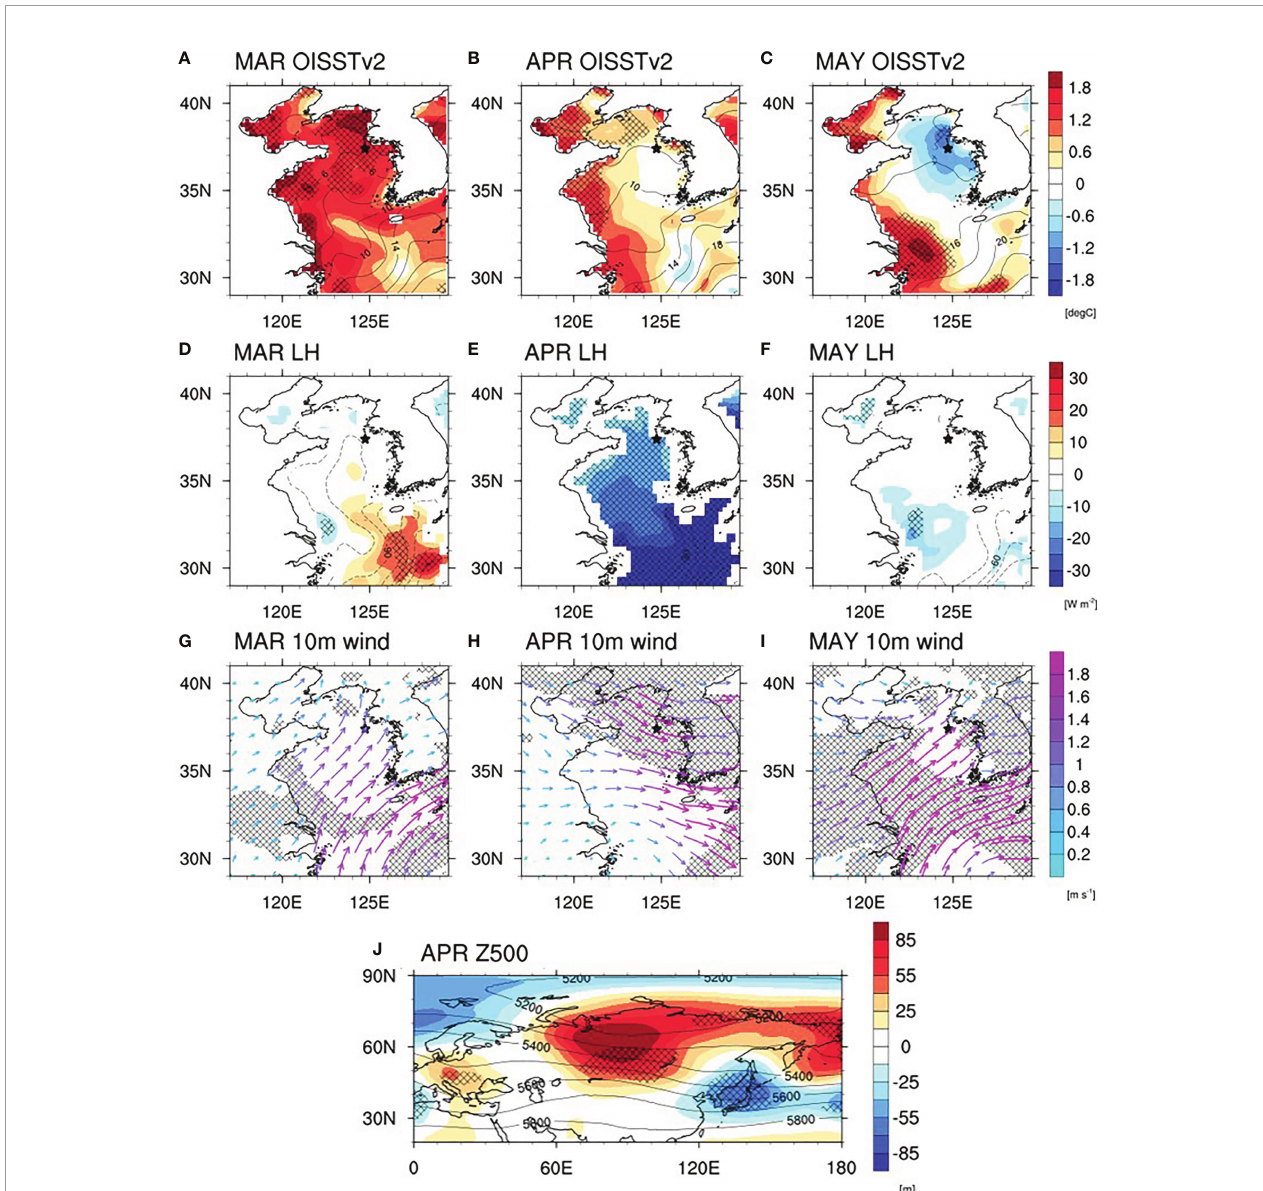
FIGURE 6 | The same as Figure 5 , but for the composite mean differences between the slow and rapid SST evolution years.